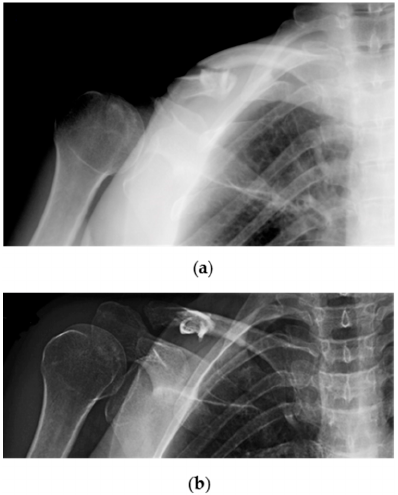
Figure 2. Radiographic images showing a traumatic displaced midshaft fracture of the right (domi- nant) clavicle in a 53-year-old female patient: ( a ) Cephalic tilt and; ( b ) anteroposterior X-ray views.